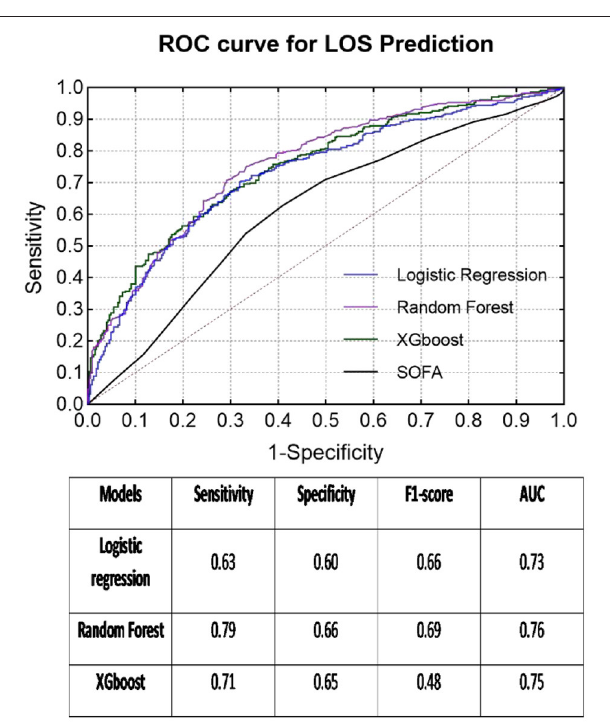
FIGURE 3 | ROC curves of each classifier for LOS prediction and classification results in the table